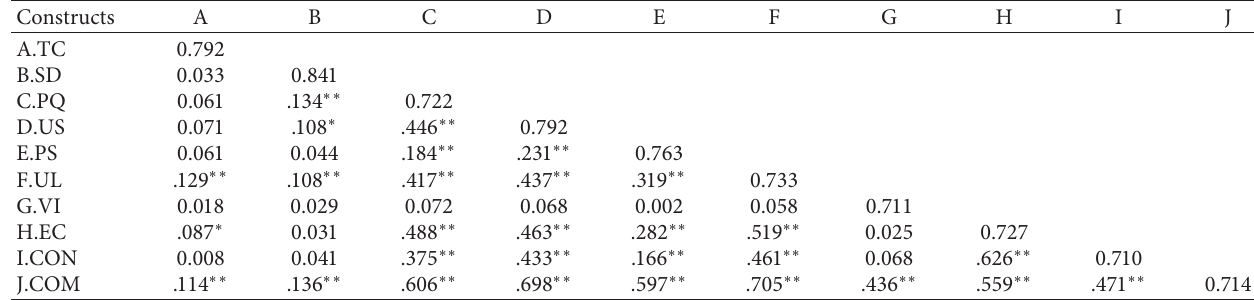
Table 6: Correlations of the constructs.